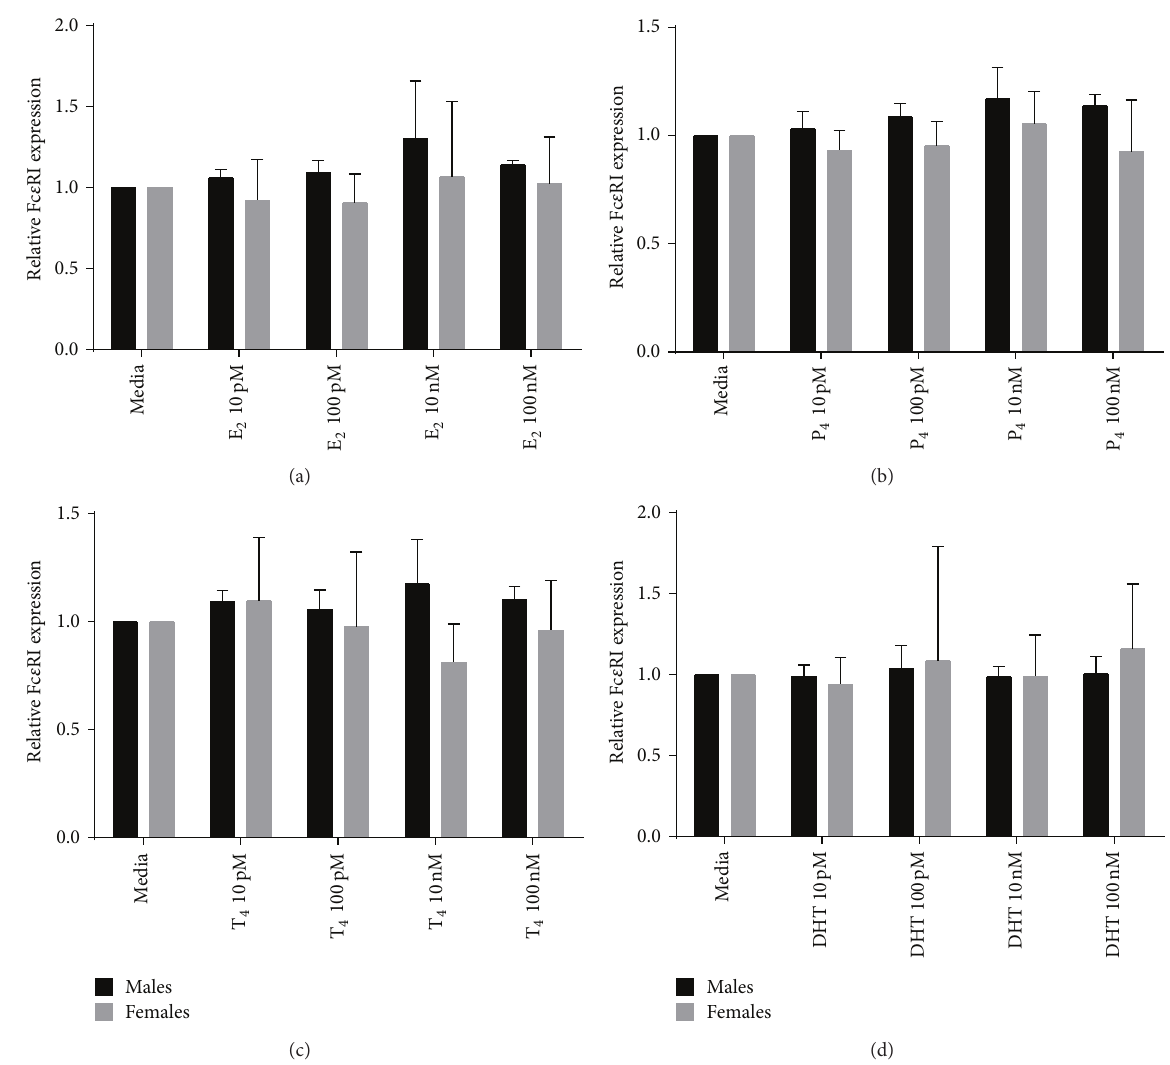
Figure 5: Fc 𝜀 RI expression induced by IgE stimulation in the presence of E 2 , P 4 , T 4 , and DHT. Fc 𝜀 RI relative expression induced by IgE stimulation in the presence of different concentrations of (a) E 2 , (b) P 4 , (c) T 4 , and (d) DHT. Relative expression was calculated as MFI (hormone-stimulated)/MFI (unstimulated control). 𝑁 = 3 for males and 𝑁 = 7 for